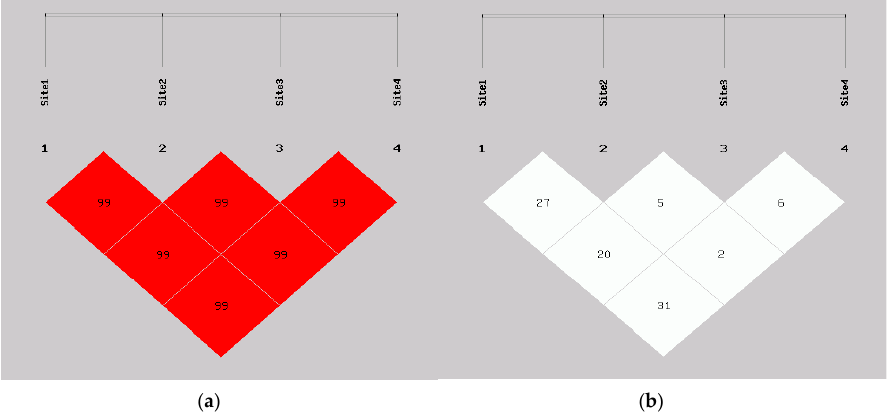
Figure 1. Linkage disequilibrium structure of four SNPs in GEMIN4 . Site1 is rs7813. Site2 is 2740349. Site3 is rs2291778. Site4 is 910924. ( a ) D’ linkage map of four SNPs in GEMIN4 ; ( b ) R 2 linkage map of four SNPs in GEMIN4 .